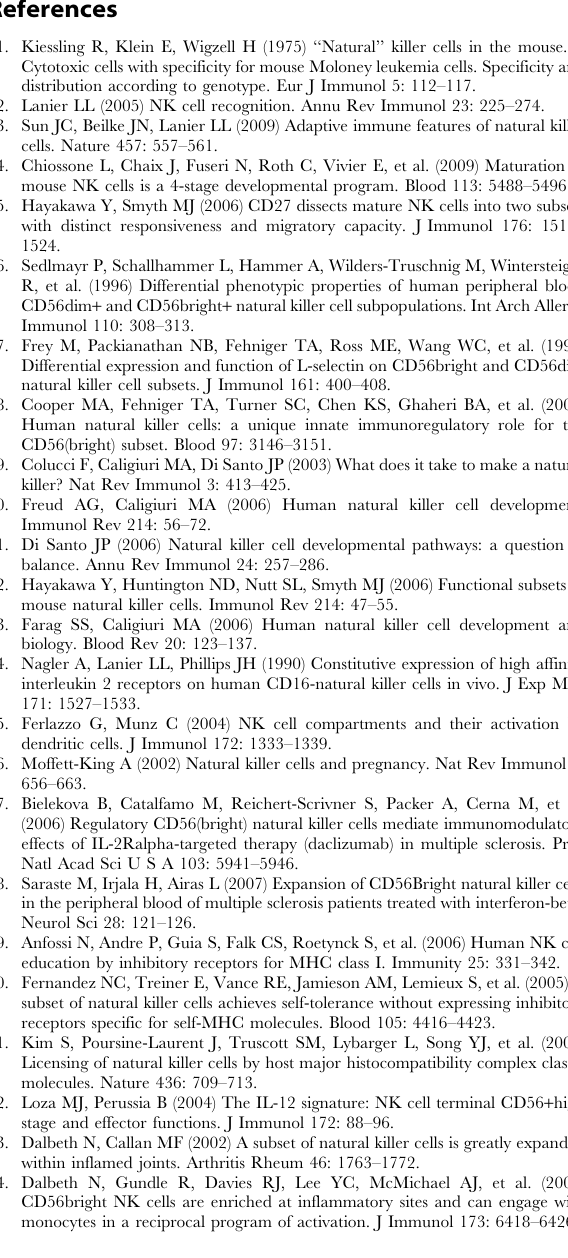
Table S1 Comparison between murine post-activation and human CD56 bright NK cell